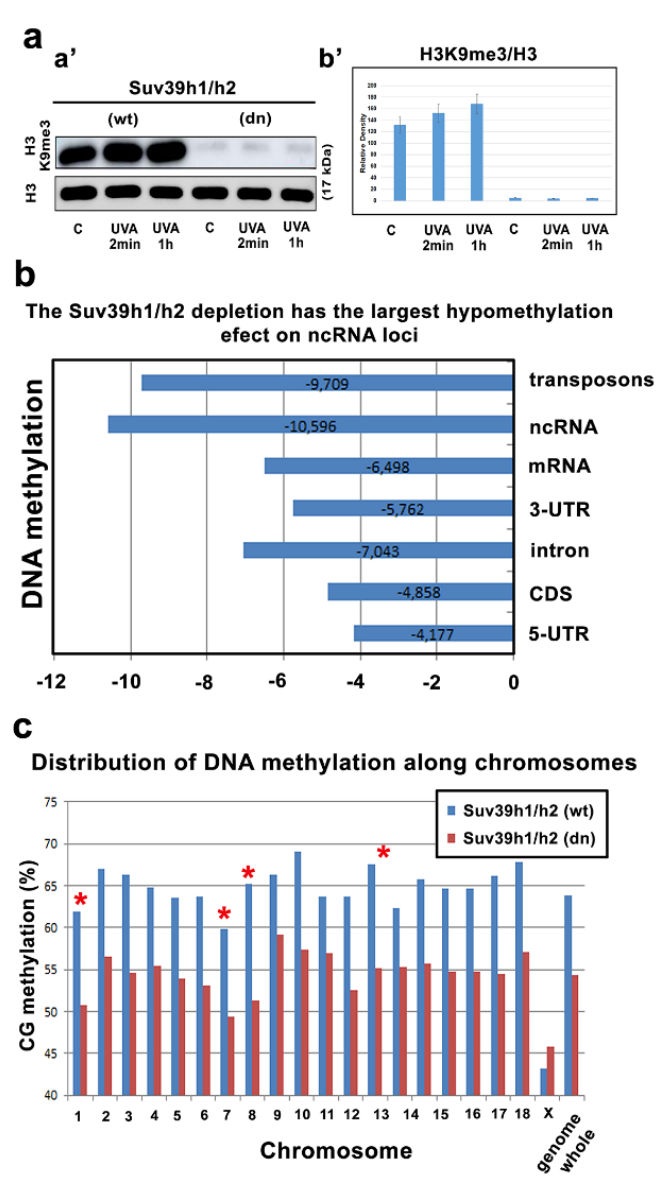
Figure 1. Suv39h1 / h2 depleted cells are characterized by global DNA hypomethylation. ( a , a’ ) H3K9me3 Figure 1. Suv39h1/h2 depleted cells are characterized by global DNA hypomethylation. ( a , a’ ) is decreased in Suv39h1 / h2 dn cells compared to the level in Suv39h1 / h2 wt cells. ( b’ ) Data from H3K9me3 is decreased in Suv39h1/h2 dn cells compared to the level in Suv39h1/h2 wt cells. ( b’ ) Data Western blot analysis were quantified by ImageJ software and normalized to the total protein levels and histone H3. ( b ) DNA methylation in distinct genomic regions was analyzed by whole-genome sequencing. The level of DNA methylation was studied in the Suv39h1 / h2 wt and Suv39h1 / h2 dn cells. ( c ) Global level of DNA methylation in individual autosomes and chromosome X in the Suv39h1 / h2 wt and Suv39h1 / h2 dn cells. Red stars show those chromosomes prone to DNA demethylation in Suv39h1 / h2-depleted cells. Asterisks (*) show chromosomes characterized by the highest level of demethylation in Suv39h1 / h2 depleted